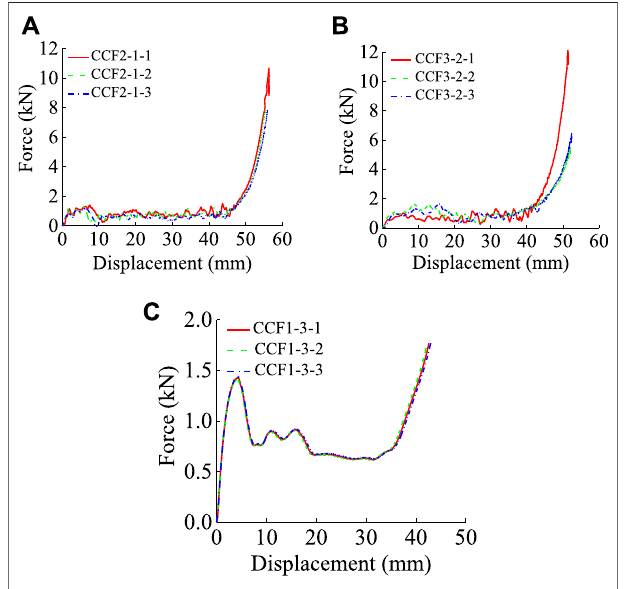
FIGURE 4 | Results of repeated experiments on NPR foams: (A) CCF2 ( _ ε (cid:2) 71.4s − 1 ), (B) CCF3( _ ε (cid:2) 2.14 × 10 2 s − 1 )and (C) CCF1( _ ε (cid:2) 4.76 × 10 − 4 s − 1 ).